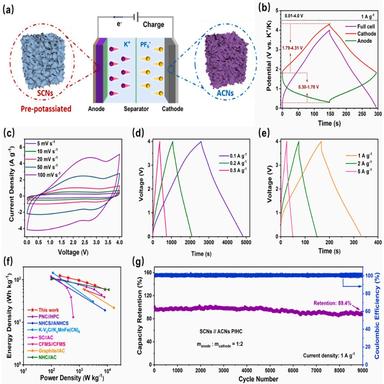
a) Schematic illustration of the SCNs//ACNs PIHCs device. Electrochemical performance of the SCNs//ACNs PIHCs at a mass ratio of 1:2: b) GCD profiles of the PIHCs system between 0.01 and 4.0 V and potential variation curves of the two electrodes at a current density of 1 A g− 1 , c) CV curves at different scan rates, d, e) GCD profiles at different current densities, f) Ragone plots of the optimal SCNs//ACNs PIHCs compared with that of the reported SIHCs and PIHCs, g) Cycling stability of the fabricated PIH